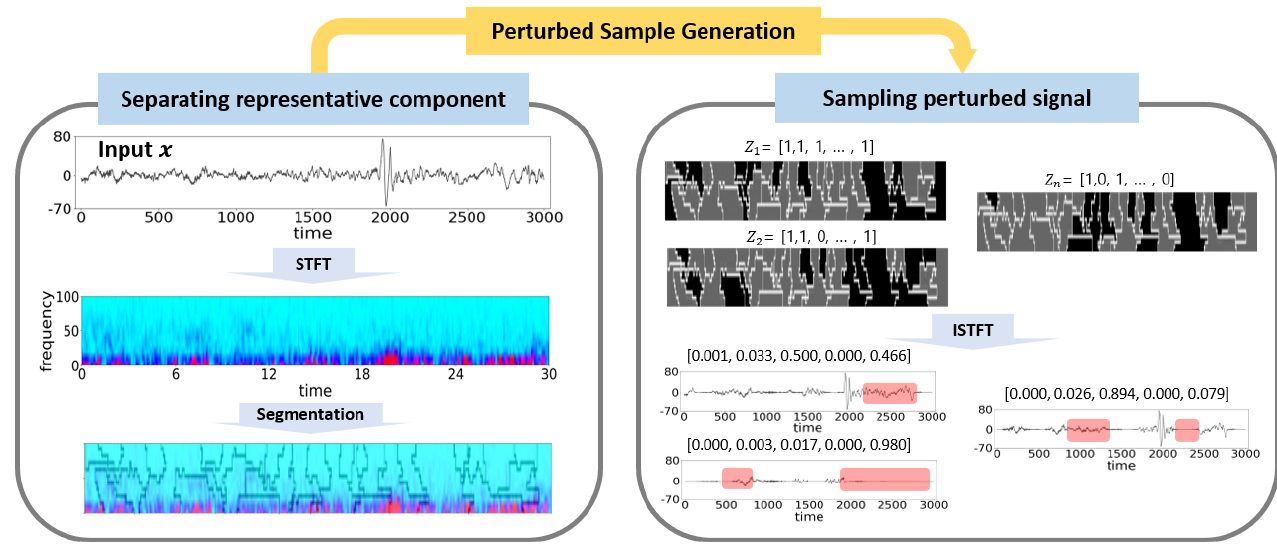
Figure 2. The process of generating perturbed samples consists of two sub processes: (1) As shown in the left diagram, given one-dimensional EEG signal x , the input is transformed using STFT. After that, it is divided using image segmentation such as Felzenszwalb [34]. (2) The divided samples are randomly permuted to generate perturbed samples as depicted at the upper side in the right diagram. Then, the perturbed samples are converted into one-dimensional signal again using